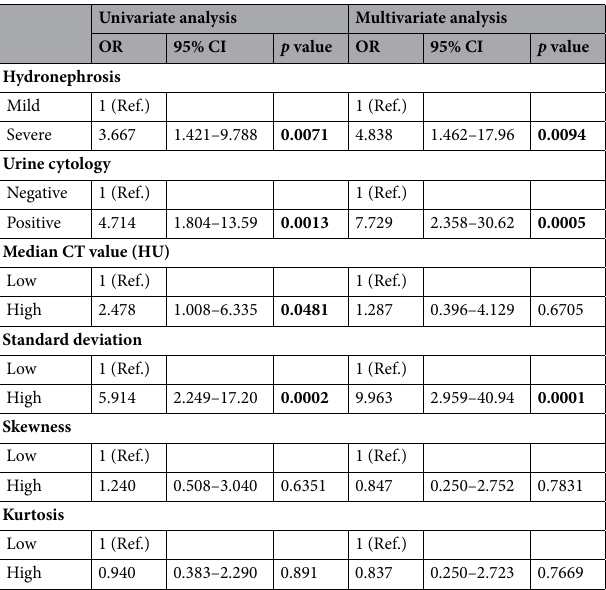
Table 3. Univariate and multivariate analysis for predicting higher T stage according to various clinical parameters. OR odds ratio, CI confidence interval, CT computed tomography, HU Hounsfield unit. The significance of bold means p < 0.05.